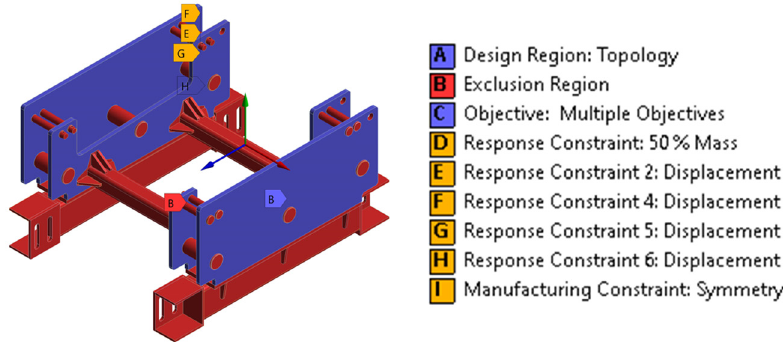
Figure 12: Topology optimization design domain. Optimization regions in blue and exclusion regions in